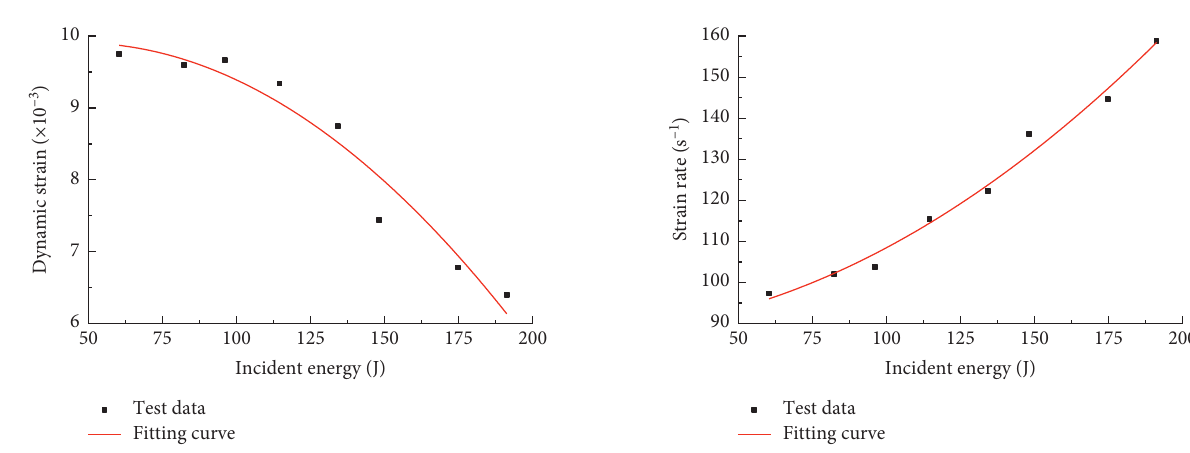
Figure 14: Relationship curve between dynamic strain and inci- dent energy.